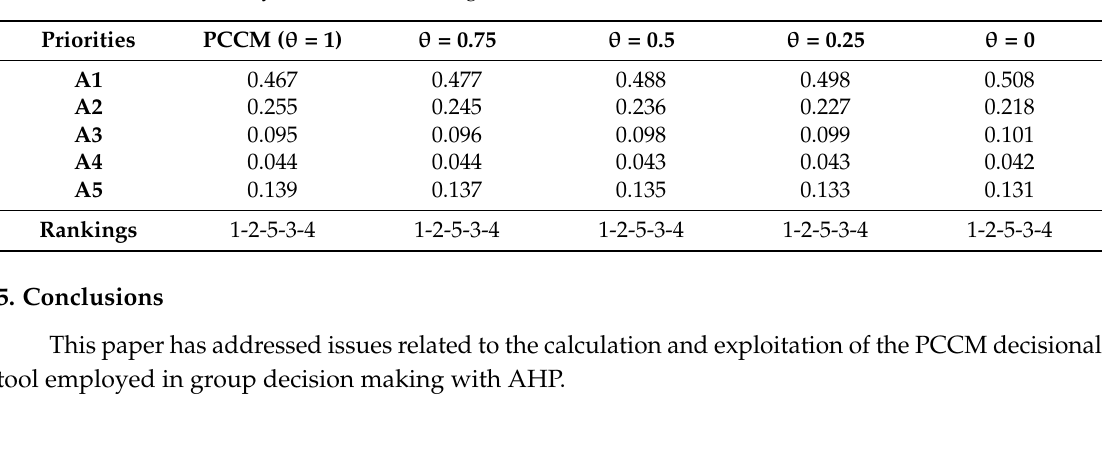
Table 11. Priority vectors and rankings for the modified PCCMs with different values of θ